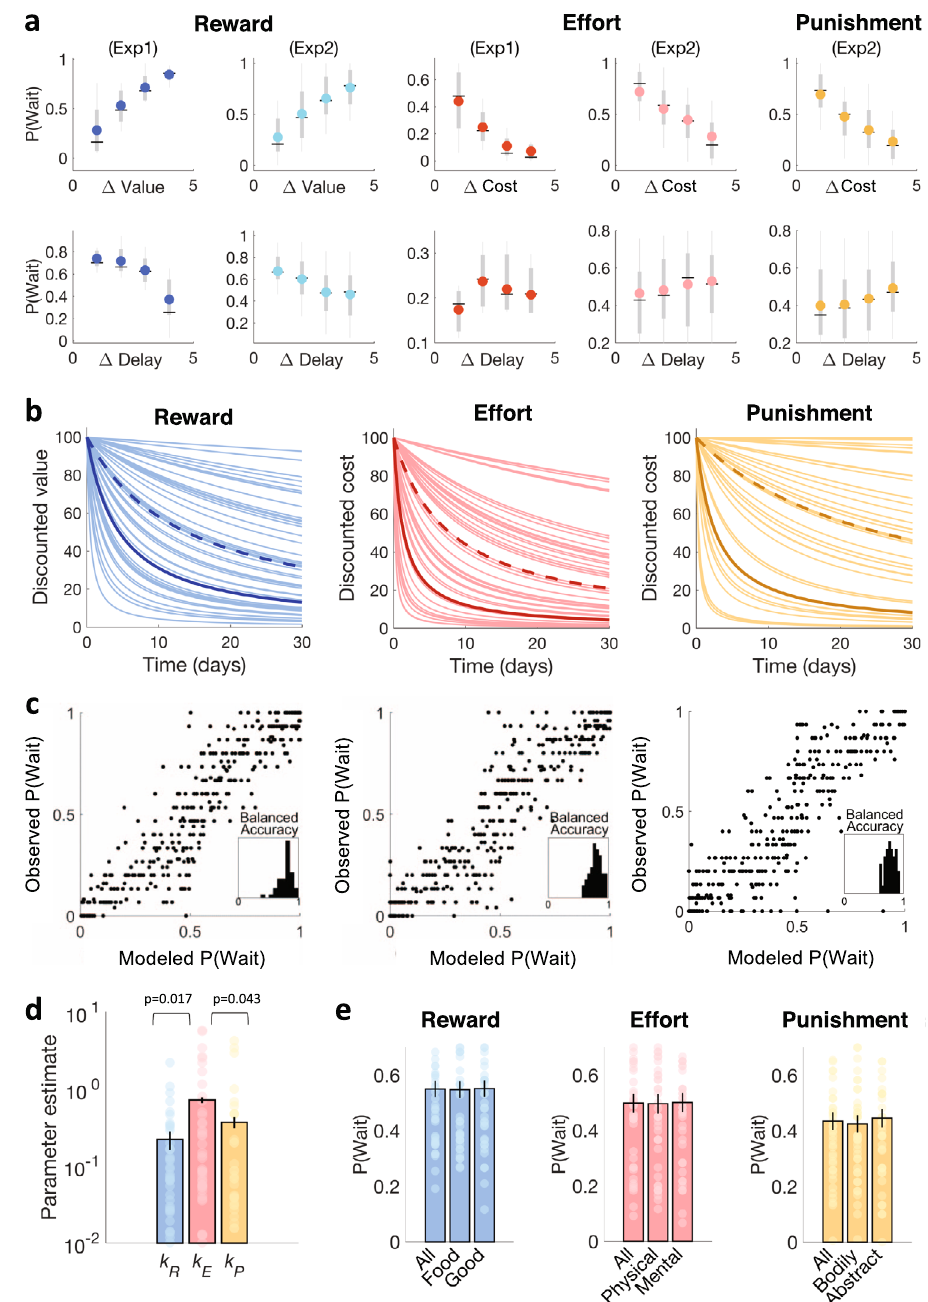
Fig.2|Timepreferences.a Intertemporal choices. Plots show patient choice rate (preference for the delayed option), as a function of the difference between optionvalues/costs(top row)oroptiondelays(bottomrow).Choiceswere made between two rewards (blue), two efforts (red) or two punishments (yellow). The twooptionsofachoicedifferedonlyindelayandvalue/cost(quantityconverted into euros based on subjective ratings). Note that value represents a gain for reward and cost a loss for effort and punishment. In Exp. 1 ( n =8 participants), rewards (dark blue) were to be received and efforts (dark red) were to be exerted atthespeci fi eddate.InExp.2( n =43participants),rewards(lightblue)weretobe received at the speci fi ed date, but efforts (light red) and punishments (yellow) could be exerted or endured at any time before the speci fi ed deadline. On each dot plot, the color mark indicates the mean, the horizonal line indicates the median, the thick whiskers indicate the range from 25th to 75th percentiles, and the thin whiskers indicate the range from 5th to 95th percentiles. b Temporal discounting of reward (left), effort (middle), and punishment (right). The plots